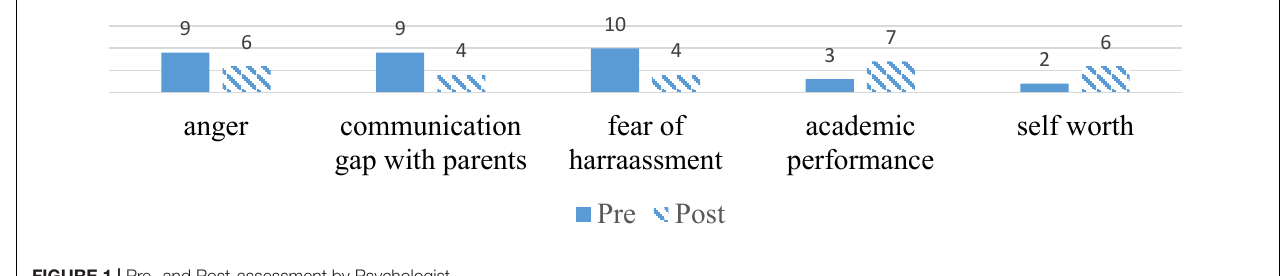
FIGURE 1 | Pre- and Post-assessment by